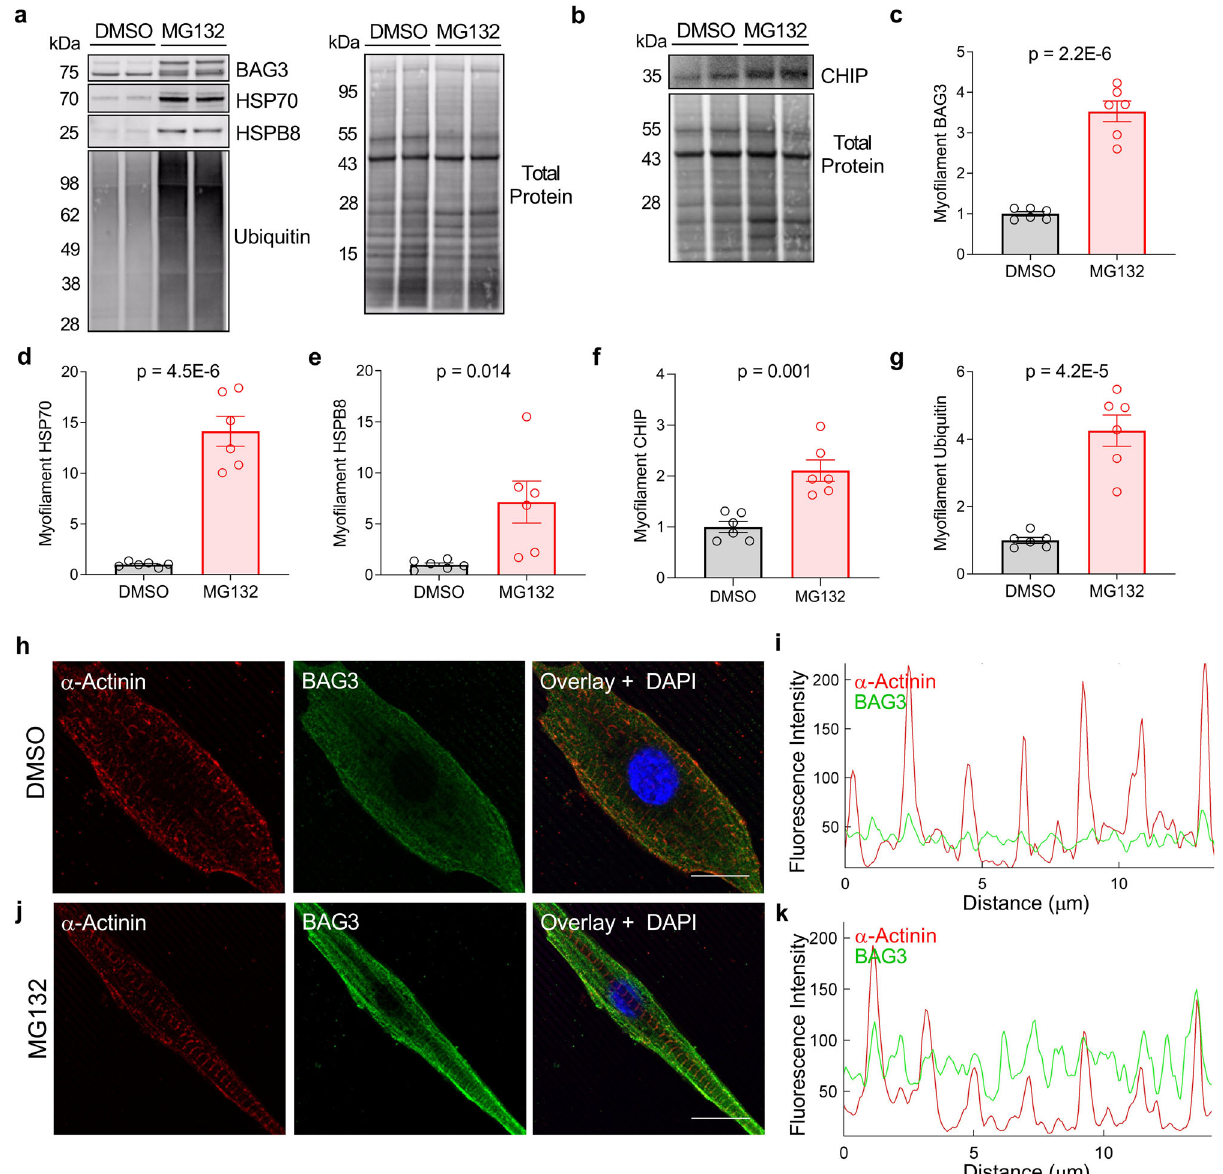
Fig. 4 The CASA complex is targeted to the sarcomere in response to proteotoxic stress. a , b Western blots for myo fi lament BAG3, HSP70, HSPB8, ubiquitin, and CHIP in neonatal rat ventricular myocytes (NRVMs) treated with vehicle (Dimethyl sulfoxide — DMSO) or the proteasome inhibitor MG132; images are representative of 3 independent experiments. c – g Quanti fi cation of myo fi lament protein expression normalized to total protein for BAG3 ( c ), HSP70 ( d ), HSPB8 ( e ), CHIP ( f ), and ubiquitin ( g ); n = 6 DMSO, 6 MG132 from 3 independent experiments; two-tailed t -test. All data are presented as mean ± SEM. h – k Immuno fl uorescence images for NRVMs treated with DMSO ( h ) or MG132 ( j ) immunostained for BAG3 and α -actinin, with quantitative line scan of fl uorescence intensity ( i , k ); ×63 magni fi cation, scale bars = 10 µ m; images are representative of 5 cells/treatment/3 independent